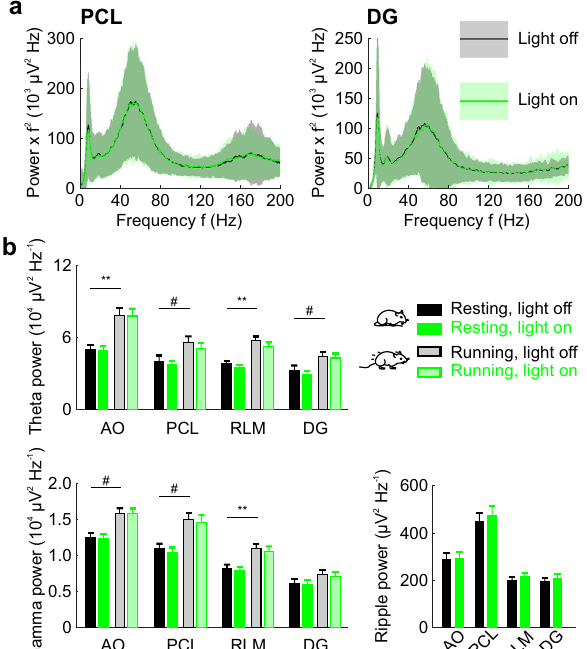
Figure 2. Optogenetic silencing of PVIs does not affect the power of hippocampal LFP oscillations. ( a ) Average power spectra of the LFP recorded in the CA1 PCL (left) or in the DG (right) during light off (black) or light on (green) periods. For illustrative purposes, power was multiplied by the squared frequency. Black and green lines are means of 136 (PCL) and 110 (DG) recordings in 7 animals, shaded areas indicate the respective standard deviations. ( b ) Total oscillation power in the theta (5–14 Hz, top), gamma (30–80 Hz, bottom left) and ripple (150–200 Hz, bottom right) frequency range during light on (green) and light off (black) periods. Episodes when the animal was sitting still (black and green bars) were analyzed separately from running episodes (grey and light green bars). Light-mediated silencing of PVIs did not lead to significant changes in the power of LFP oscillations. In contrast, during running theta and gamma power was significantly higher in different anatomical regions. Ripple events only occurred during resting periods of the animal. AO, alveus/oriens; PCL, pyramidal cell layer; RLM, radiatum/lacunosum-moleculare; DG, dentate